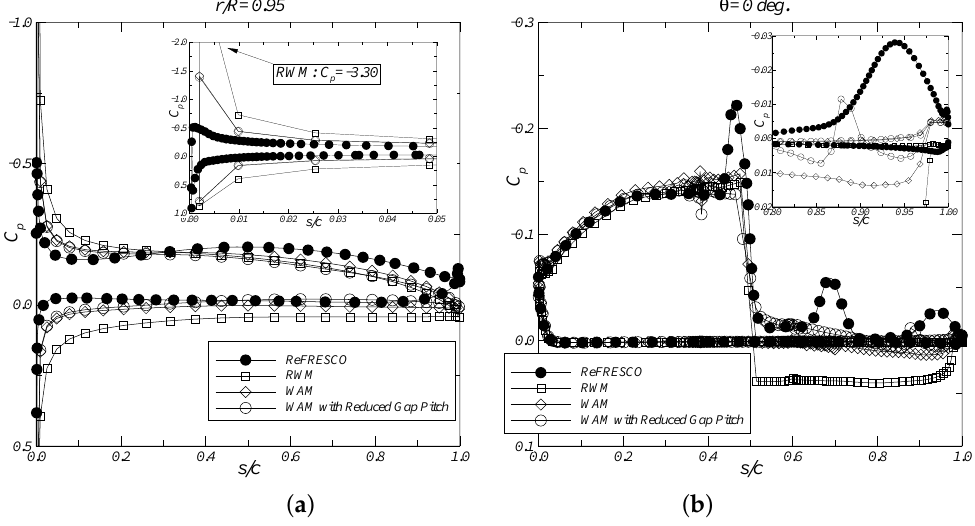
Figure 11. Blade chordwise pressure distribution at r / R = 0.95 ( a ); Duct chordwise pressure distribution at θ = 0 degrees ( b ). J =